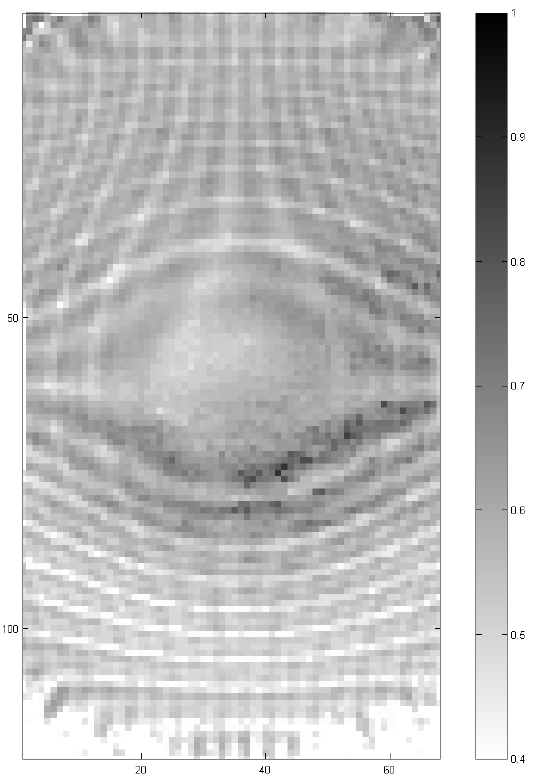
Figure 9: The sharpness estimate for streetside experiment ex- hibits the grid used for the correction of the